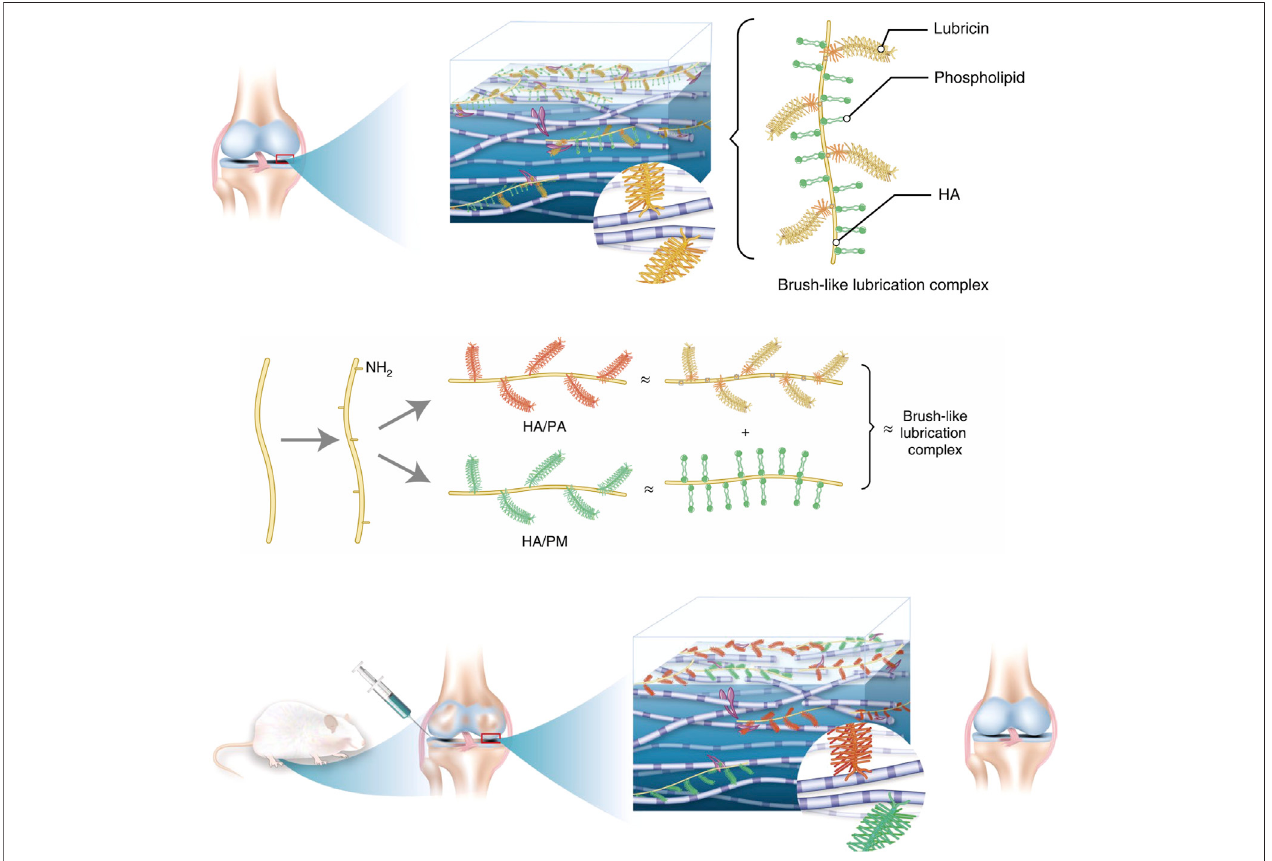
FIGURE 3 | Schematic of the ideation. Illustration of the composition and structure of the lubrication complex in the normal joint. Preparation of biomimetic lubricants(HA/PAandHA/PM)thatmimicthestructuresofthenaturallubricationcomplexandcanbeusedtorestorethelubricationpropertyofthejointinearlyOAmore ef fi ciently. Reproduced with permission from Xie R. et al., Nat Biomed Eng; published by Springer Nature, 2021.